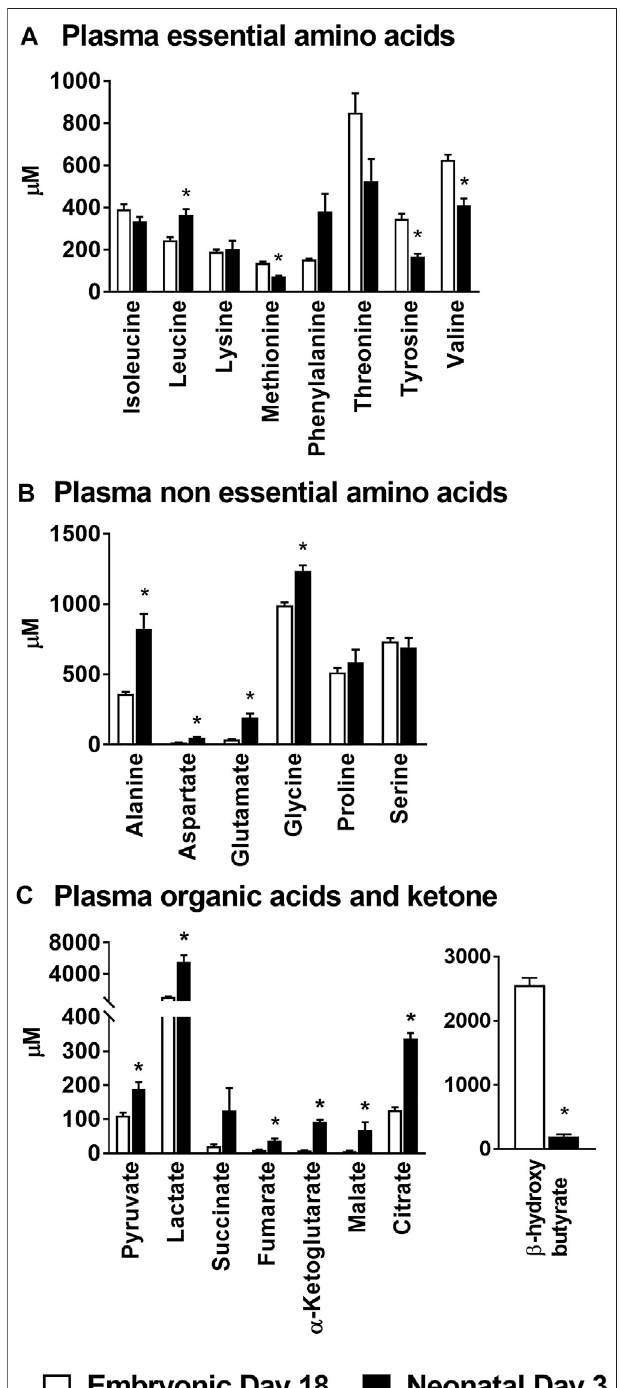
FIGURE 1 | Changes in plasma amino acids, organic acids and β - hydroxybutyrate during embryonic-to-neonatal development. Plasma concentrations of (A) Essential amino acids; (B) Non-essential amino acids; (C) Organic acid intermediates of the TCA cycle and β -hydroxybutyrate in broiler embryos and neonates. All the values are represented as means ± SEMwith n =6 – 9birds/group.Resultswereconsideredsigni fi cantat p ≤ 0.05 (*) following a Student t -test between embryonic day 18 and neonatal day